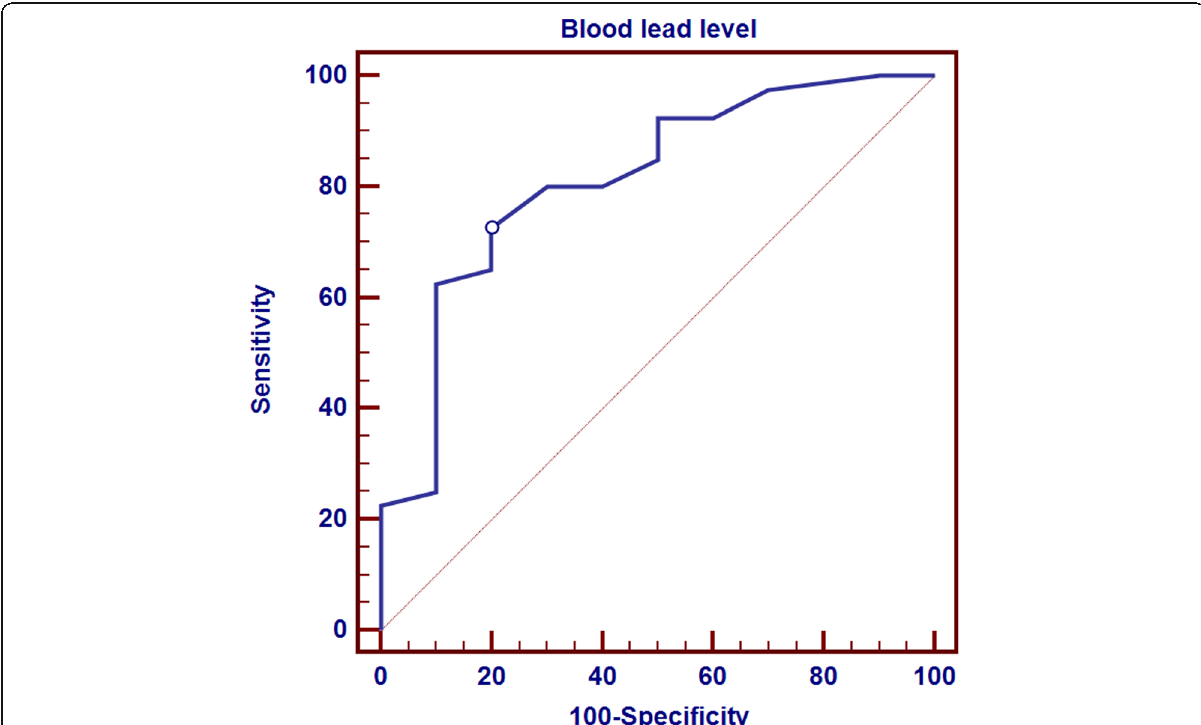
Fig. 1 ROC curve for sensitivity and specificity of BLL in predicting